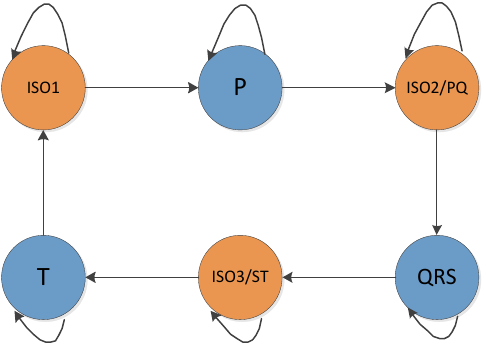
Figure 9. HMM hidden states in ECG waveform left-right